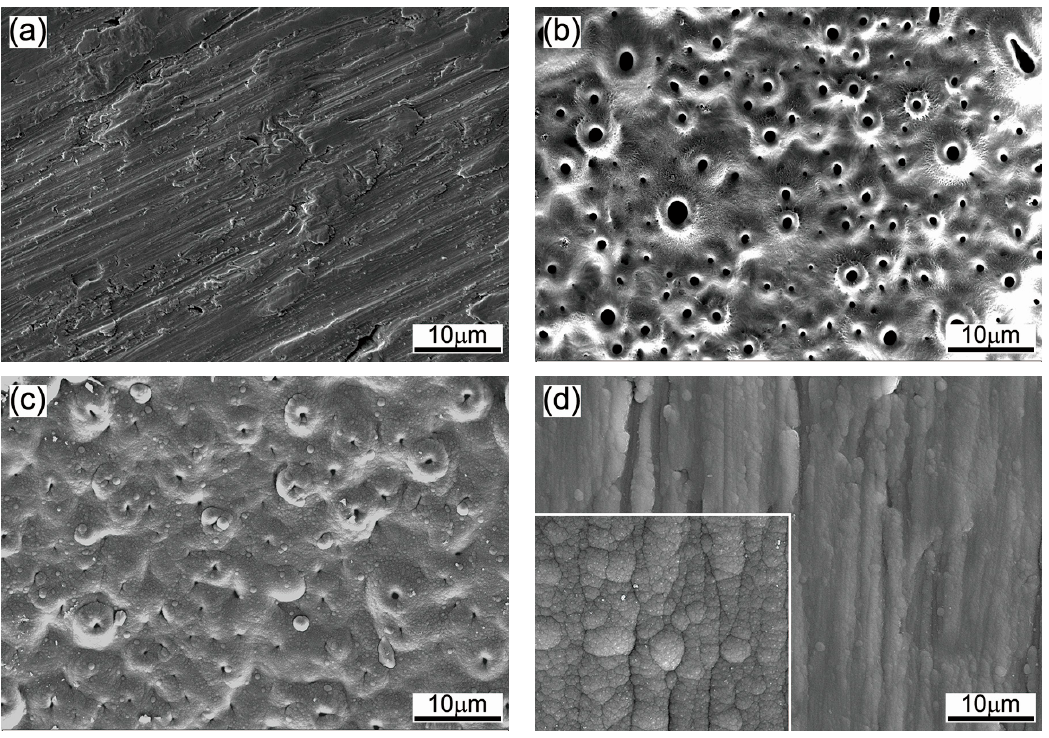
Figure 1. Surface morphologies of ( a ) titanium substrate, ( b ) anodic TiO 2 film, ( c ) TiO 2 /diamond-like carbon (DLC) composite coating, and ( d ) DLC mono-film.